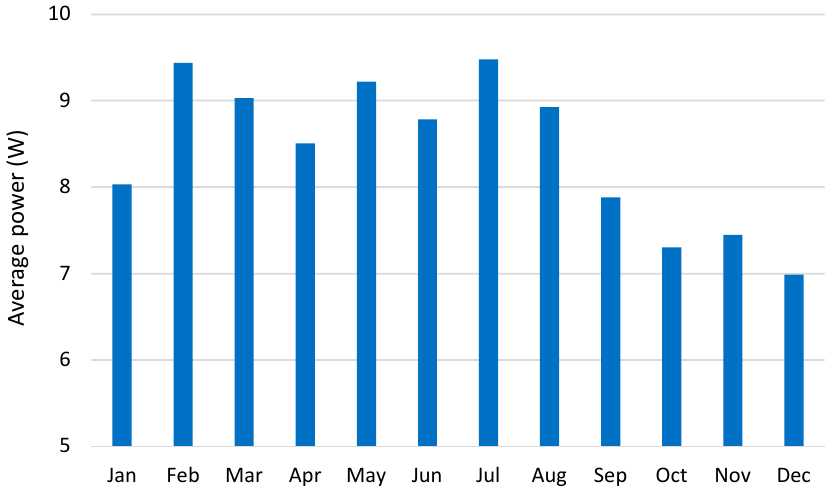
Figure 13. Average power generation by the solar panel for the year 2020.